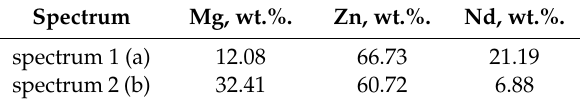
Table 4. Values of spectra of Mg–Zn–Nd master